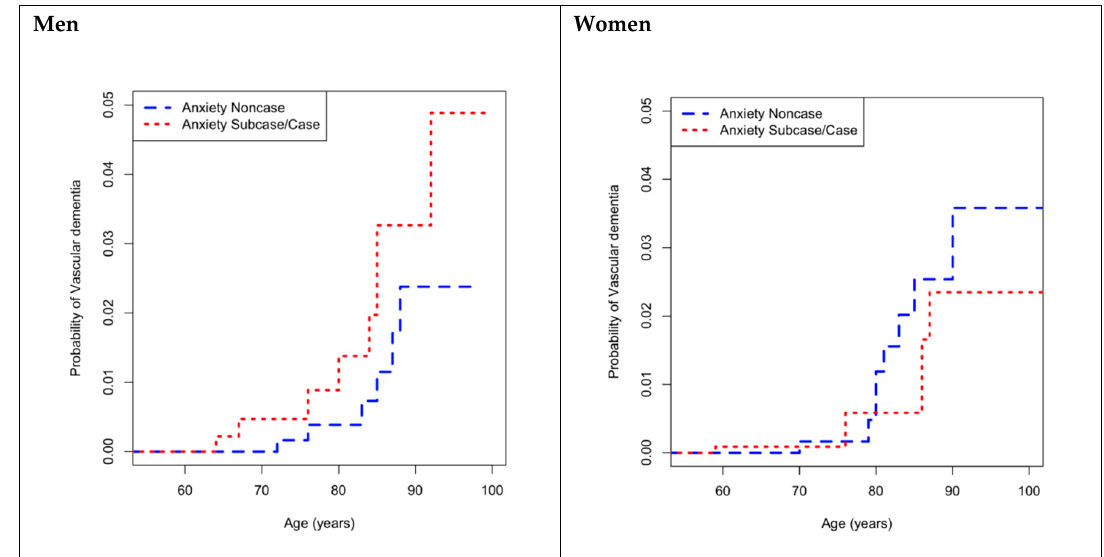
Figure 2. Cumulative incidence functions for incident VaD according to anxietystraitified by sex. VaD: vascular dementia.